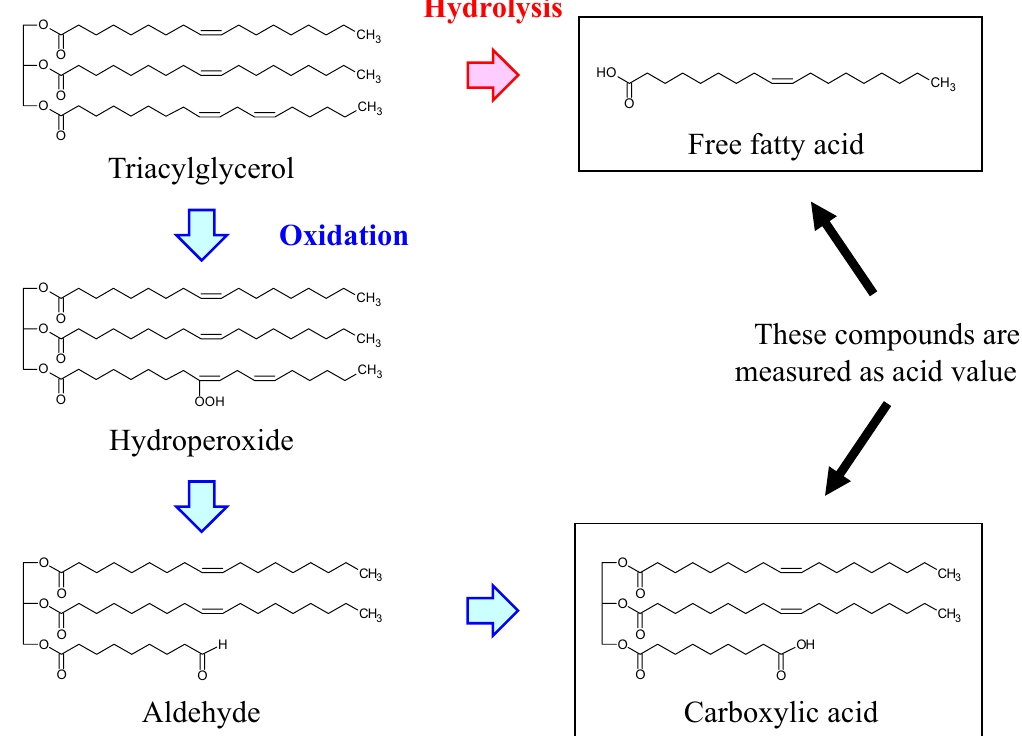
Figure 1. Hypothesis regarding the formation of carboxylic acids by the heating of canola